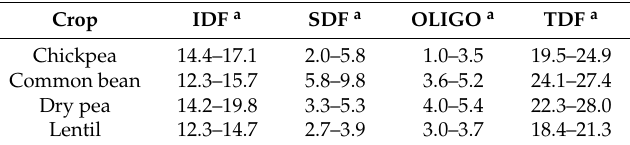
Table 6. Range of dietary fiber content (%) among pulse crops.